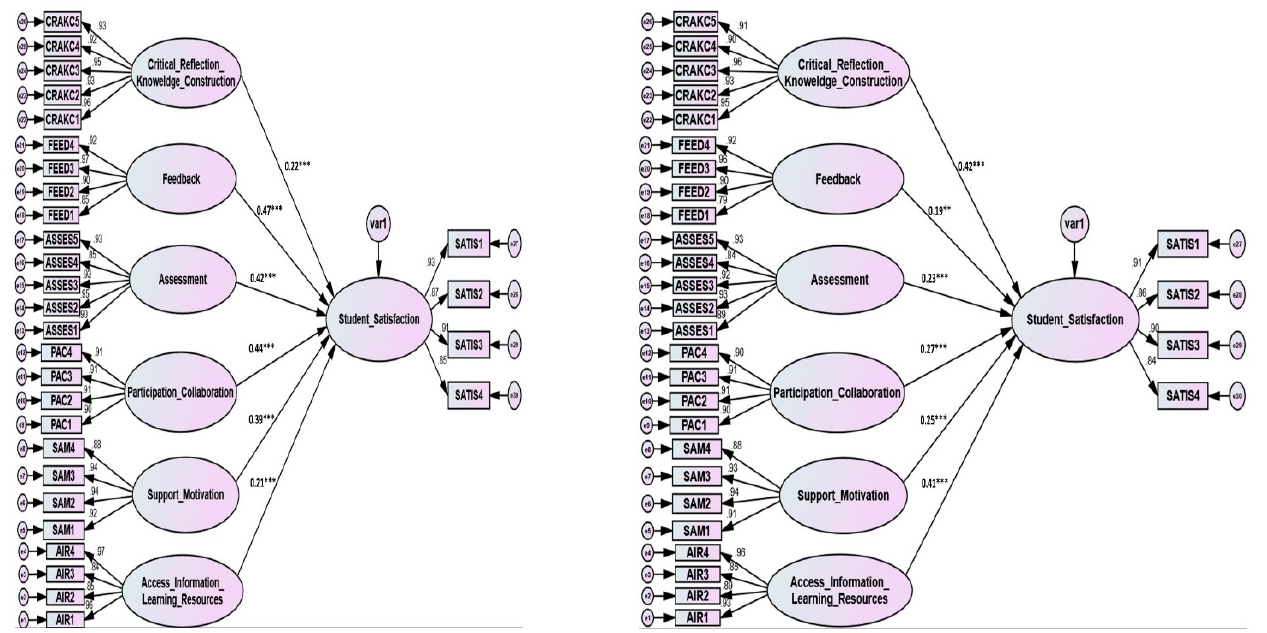
Figure 1. The structural results for the two comparative models (before and amid COVID-19).